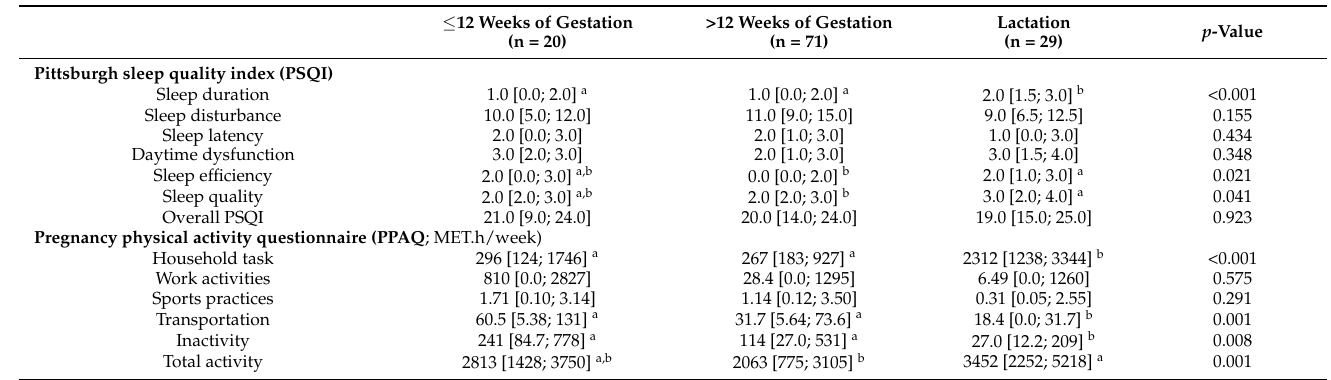
Table 3. Differences in sleep quality index and physical activity in between groups.